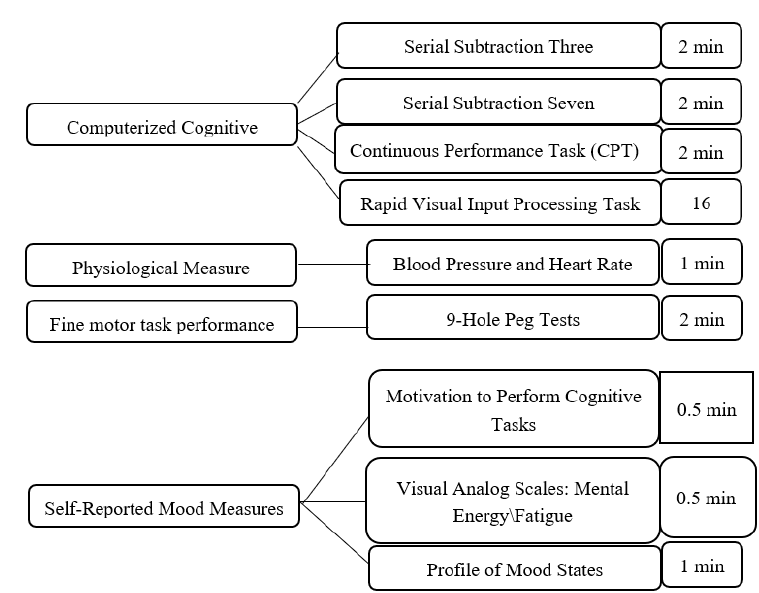
Figure 2. Tests and measures.